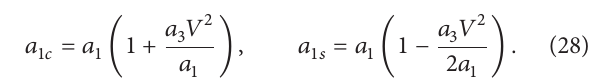
which, differently from the case of ILFD with saturation-like nonlinearity, do not depend on the circuit